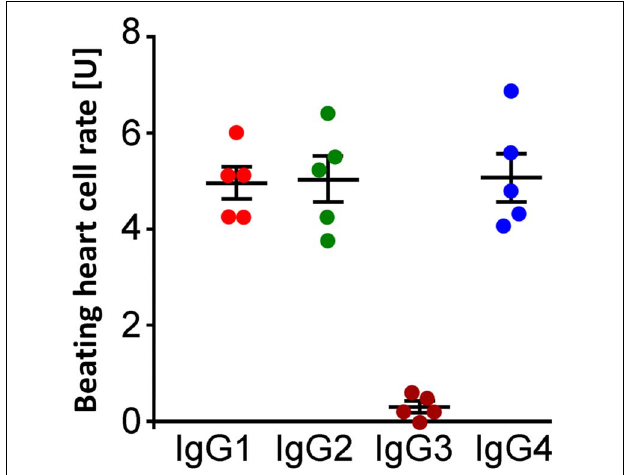
FIGURE 7 | Identification of IgG3 subclass of β 2 -agAAbs from patients with PEX glaucoma. Beating heart cell rates after incubation pretreated with anti-human IgG1 (red), IgG2 (green), IgG3 (dark orange), and IgG4 (blue); absolute date, mean ± standard deviation (SD); 1 unit (U) reflects 4 beats/min. The increase in the beating heart cell rate was eliminated only after incubation with anti-human IgG3 (dark orange). Only peptides against IgG3 inhibited the agonistic nature of β 2 -agAAbs, visualized by the increase of the beating heart cell rate. Consequently, the agonistic β 2 -agAAbs are of the IgG3 subtype.